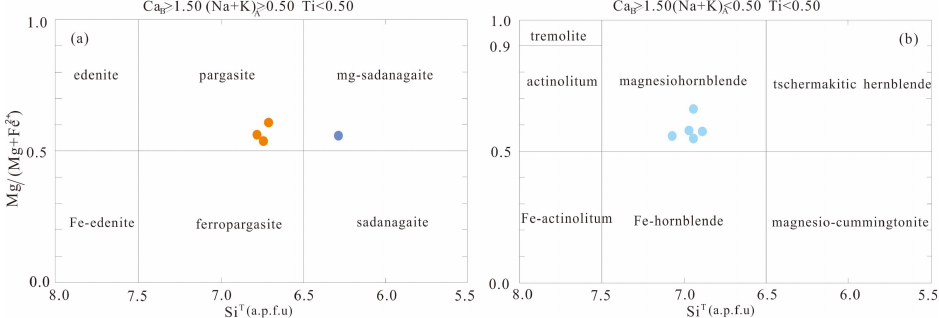
Figure 7. Classification of amphibole from the Zhouguan granodiorite